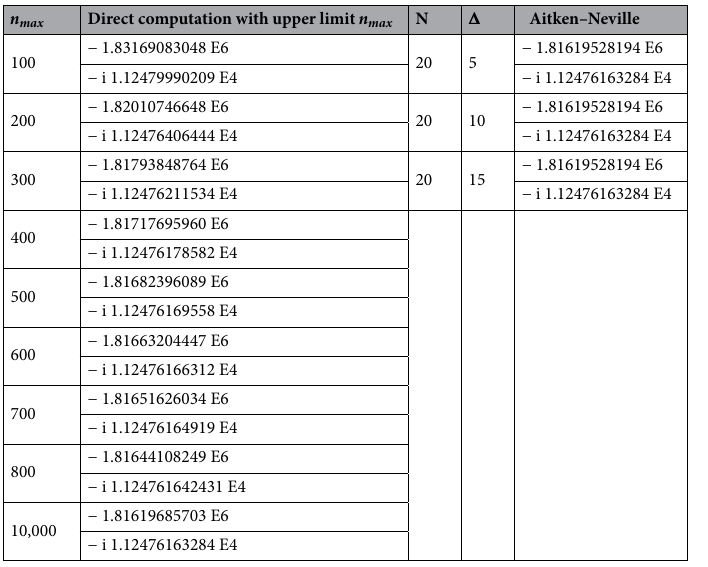
see (48) with l (cid:29)